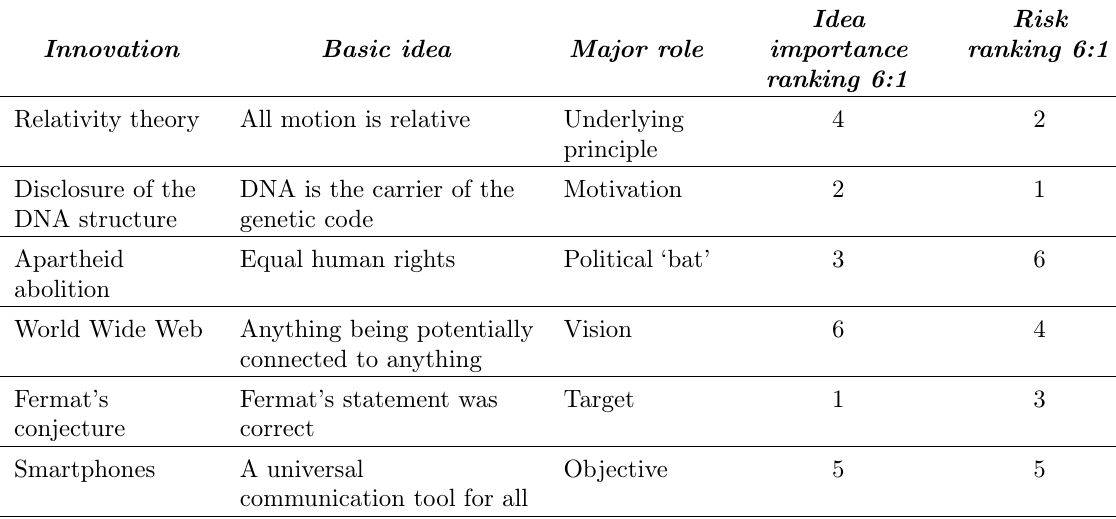
Table 1. The major roles, importance and risks of the basic ideas in each one of the innovation